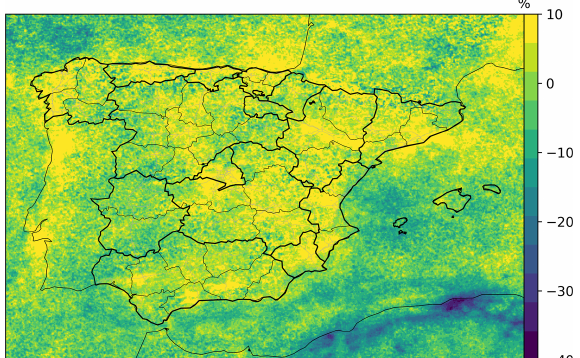
Figure G6. Mean relative change of TROPOMI TrC-NO 2 on Friday (which corresponds to the occidental “Sunday” in Algeria), relative to the other days (Monday–Tuesday–Wednesday–Thursday–Sunday). Black lines, grey lines and hatched areas correspond to administrative borders, Spanish major roads and functional urban areas, respectively (sources: see Sect. 2.4).